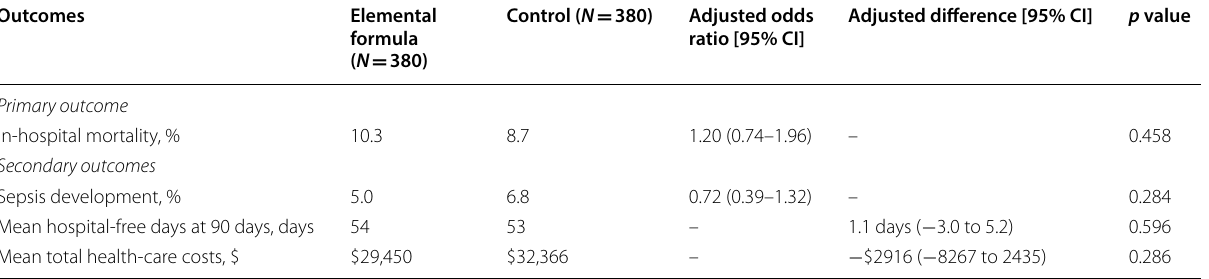
Table 3 Results of propensity score matching